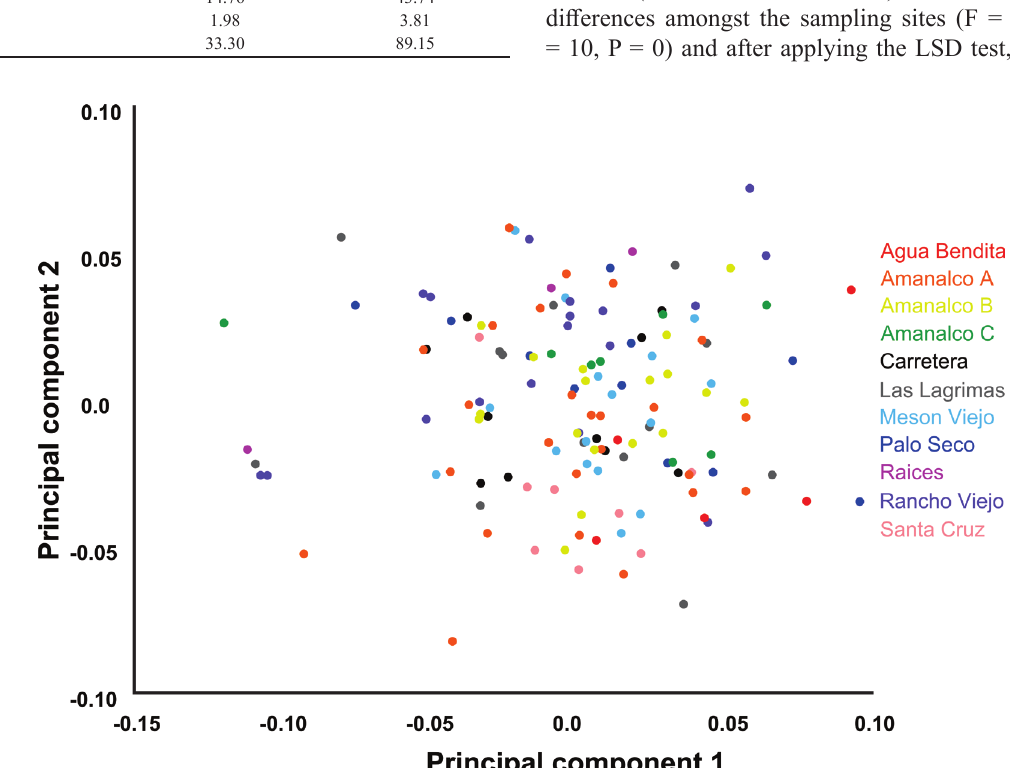
Figure 4. PCA analysis of head dimensions of adult P. robertsi